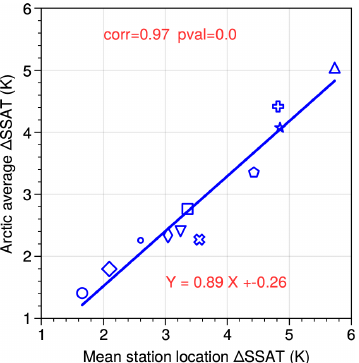
Figure 8. Modelled Arctic-wide (cid:49) SSAT versus modelled mean (cid:49) SSAT at the data locations for the 11 models. The markers for each model are the same as in Fig.